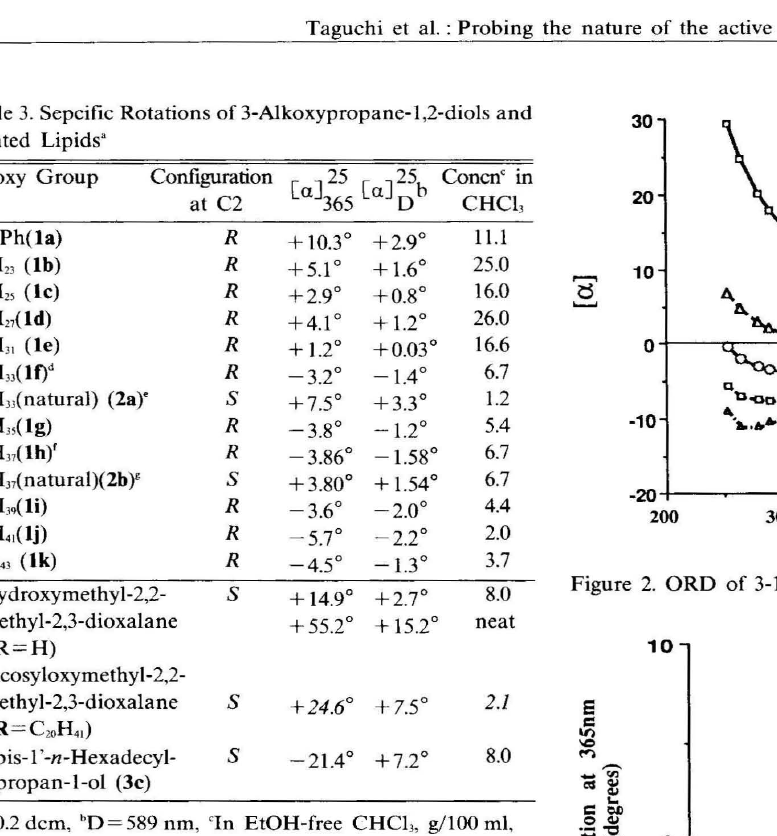
Figure 2. ORD of 3-1'-tridecyloxypropan-I,2-diol in CHCI,